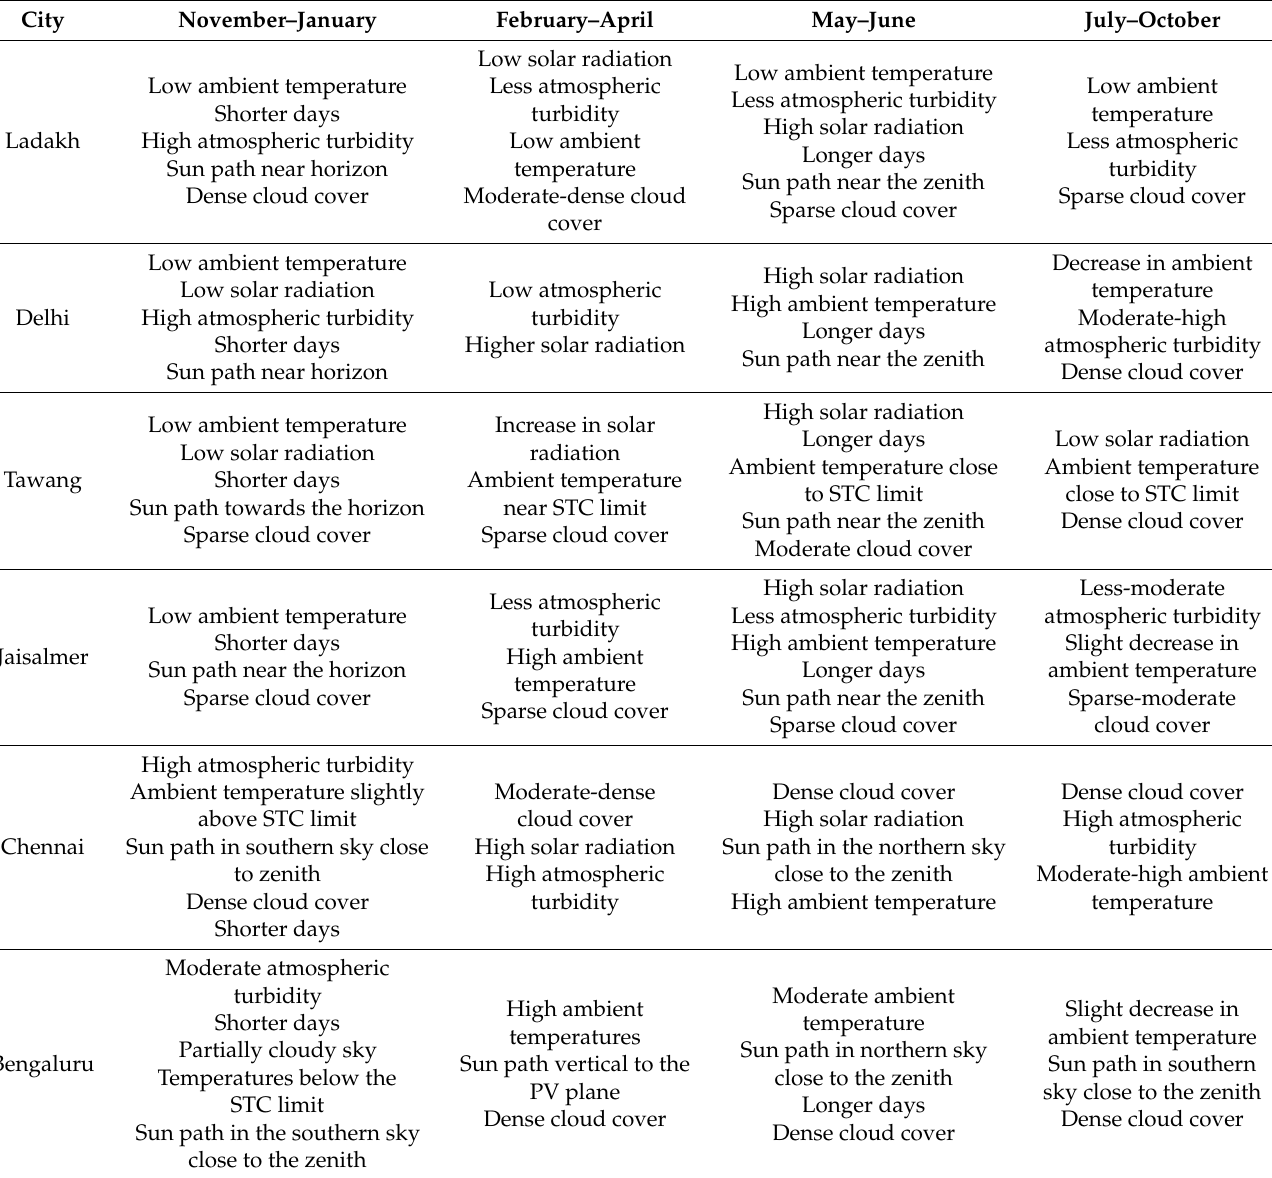
Table 7. Factors affecting the monthly energy supplied by the system in all six